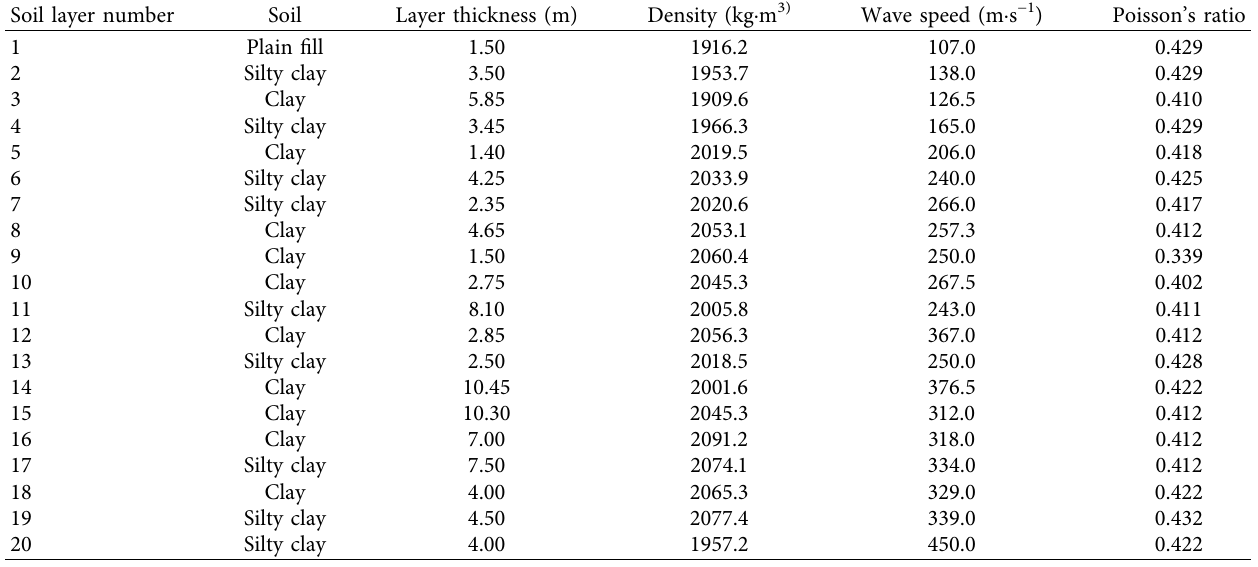
Table 1: Soil material parameters.